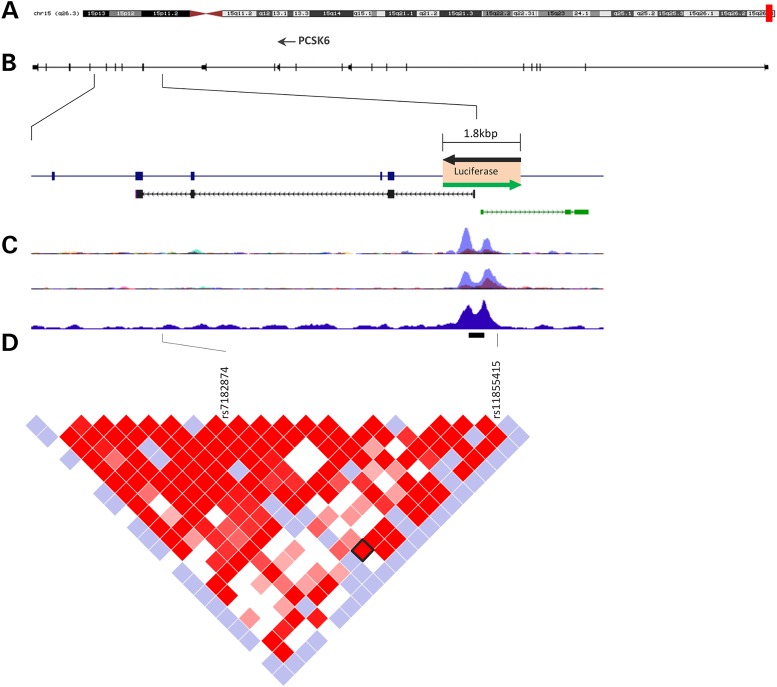
PCSK6 locus associated with relative hand skills. (A) PCSK6 is located on chromosome 15q26.3 as indicated by the red box. (B) PCSK6 structure and expanded view of the region where top associations with relative hand skill cluster (5,6). Both sense (black) and antisense (green) transcripts are predicted to originate within this region, as shown by the human spliced EST and GENCODE tracks from the UCSC Genome Browser (http://genome-euro.ucsc.edu), respectively. A 1.8 kb region (orange box) was cloned into luciferase reporter vectors in both directions (black and green arrows). (C) This region is predicted to contain regulatory elements as shown by UCSC tracks for Chip-SEQ ENCODE (10). From top, the tracks show H3K27Ac and H3K4Me3 histone marks in different cell lines where the highest peak corresponds to the K562 cell line. RNA polymerase II binding for the K562 cell is shown in the third track. (D) The genetic associations cluster within a 12.7 kb LD region, visualized as D′ values, in HapMap CEPH data. The black bar indicates the position of the rs10523972 VNTR. Rs7182874, the strongest associated marker in the most recent GWAS (6), is in high LD (black diamond) with rs11855415, which was the top associated marker in the discovery sample (5) and shows functional allelic effects in the present study. LD visualization of the surrounding region is shown in Supplementary Material, Figure S1.